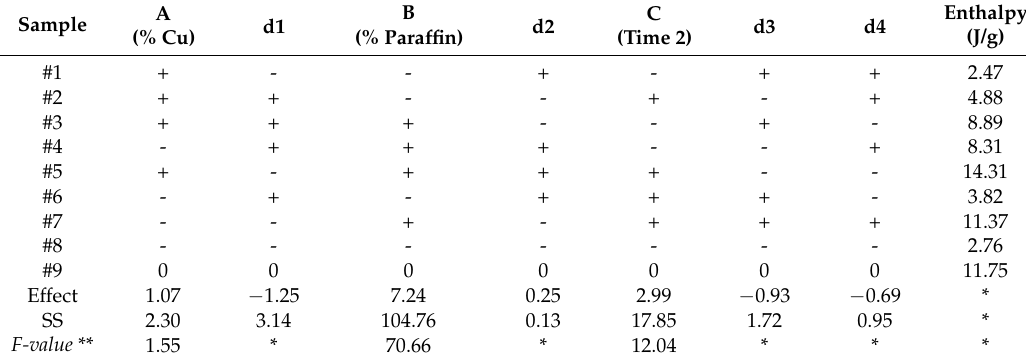
Table 4. Plackett-Burman experimental design matrix and enthalpy results obtained from DSC.